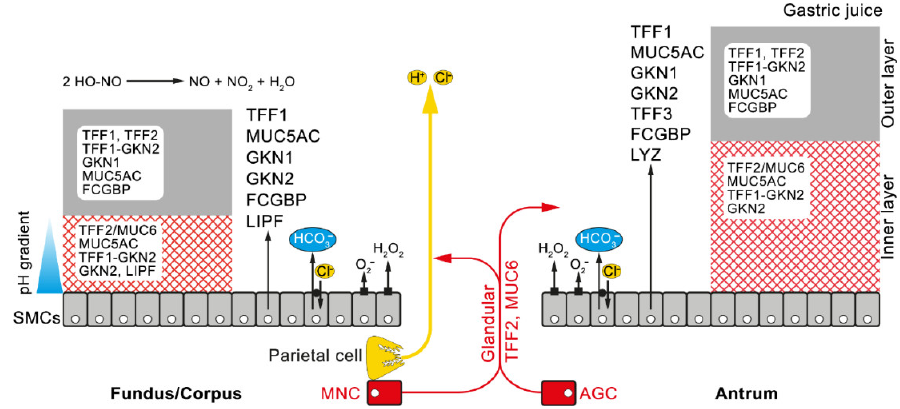
Figure 2. Model of the gastric mucus–bicarbonate barrier in the fundus/corpus and the antrum, respectively. The gastric mucus consists of an outer and an inner layer and originates from different cell populations, i.e., surface mucous cells (SMCs) and glandular cells (fundic mucous neck cells (MNCs) and antral gland cells (AGCs); shown in red). The SMCs in the fundus and corpus differ somewhat and they originate from different stem cells (review: [130]). Both SMC types synthesize TFF1, the mucin MUC5AC, and the gastrokines GKN1, and GKN2, whereas the fundic SMCs additionally secrete gastric lipase (LIPF), and the antral SMCs, lysozyme (LYZ), TFF3, and the major portion of Ig Fc binding protein (FCGBP) [117]. The MNCs and AGCs secrete TFF2 and the mucin MUC6 and the TFF2 / MUC6 complex are expected to form the rather insoluble matrix of the inner layer. Further components of the inner layer are MUC5AC and probably TFF1–GKN2 and GKN2. The very hydrophobic LIPF is expected to be a component of the inner fundic mucus layer [117]. SMCs also secrete bicarbonate (HCO 3 − ; shown in blue) in exchange with Cl − creating a pH gradient along the inner layer. The dual oxidase (DUOX) in SMCs and the NOX enzymes generate H 2 O 2 and O 2 − , respectively, at the apical surface, restricting microbial colonization (innate immune defense). The formation of NO in the gastric juice by the disproportionation of HO-NO is also